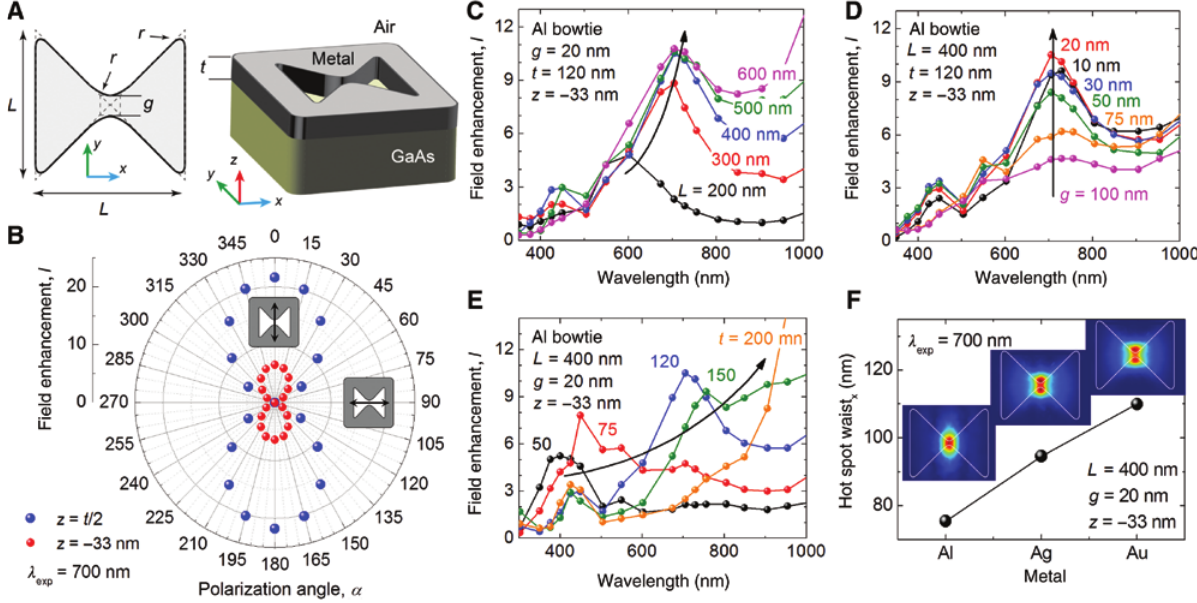
Figure 1: Bowtie NA simulations by FEM calculations.